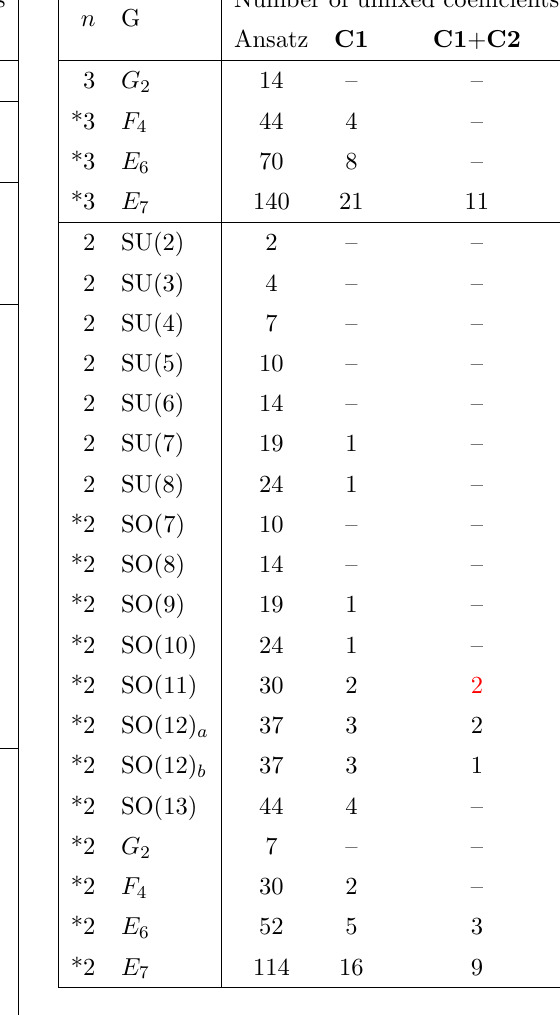
Table 23. Fixing the Ansatz for n (cid:21) 2. For each theory, we (cid:12)rst list the total number of un(cid:12)xed coe(cid:14)cients in the Ansatz, and in the remaining columns the number of coe(cid:14)cients left un(cid:12)xed after imposing successively the constraints C1 and C2 . For the theory h SO(11) table entry. We pre(cid:12)x by an asterisk the theories for which our results are